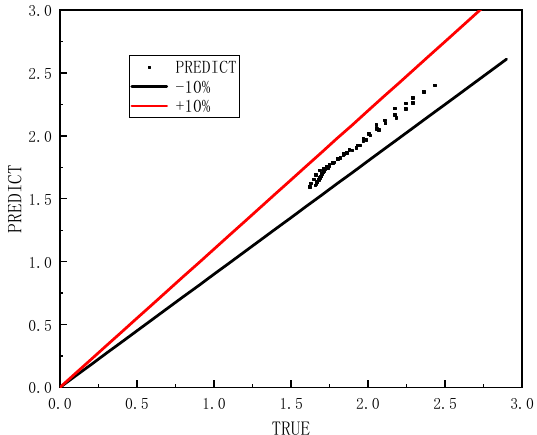
Figure 25. Comparison between predicted results and calculated results (0°–30°). When the defect was located at 30–60°, an equivalent analysis was carried out by the result of the defect located at 45°. The limit state of the pipeline is shown in Figure 26. When the defect was located at 30°–60°, the critical failure load of the pipeline was significantly greater than those of pipelines with defects located at 0° and 90°. When the defect depth is greater than 0.4, defect depth will have a more significant impact on the critical failure load.